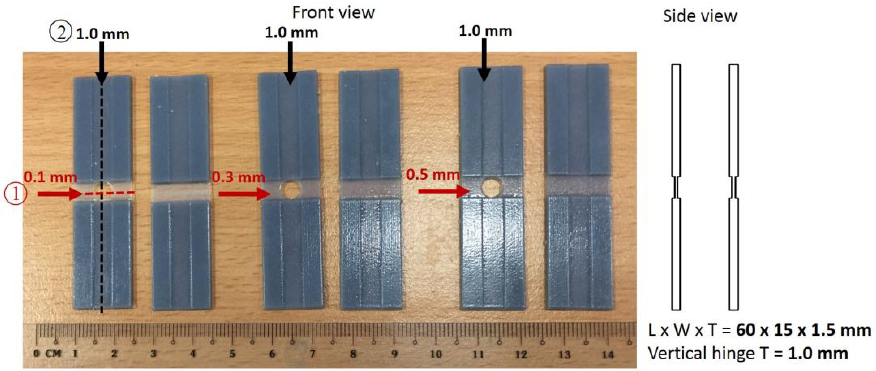
Figure 4. Structures with crossed folding lines of different thicknesses.